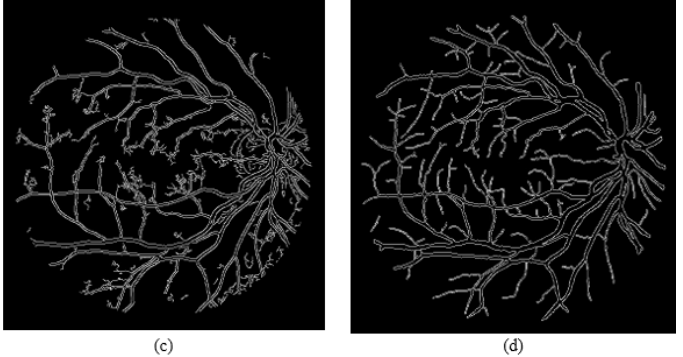
Figure 15. Comparison of segmented images for Photo 1 . ( a ) Input image. ( b ) Segmented image using the proposed approach (GUI based). ( c ) Segmented image using Canny detector with ideal parameters. ( d ) Ground truth image from DRIVE dataset.